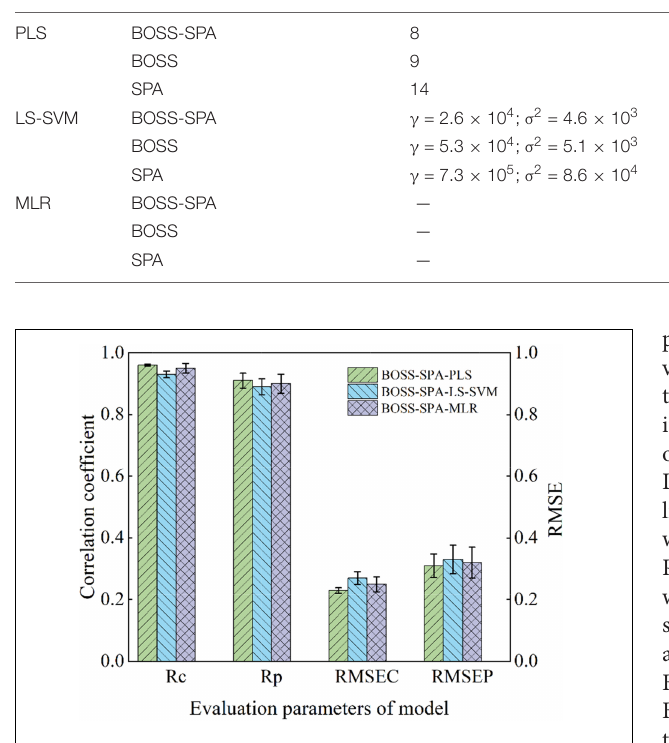
were 0.89–0.93 and 0.23–0.32 ◦ Brix, respectively. Compared with full-spectrum PLS and LS-SVM models in Table 3 , the models based on effective variables obtained similar or even better